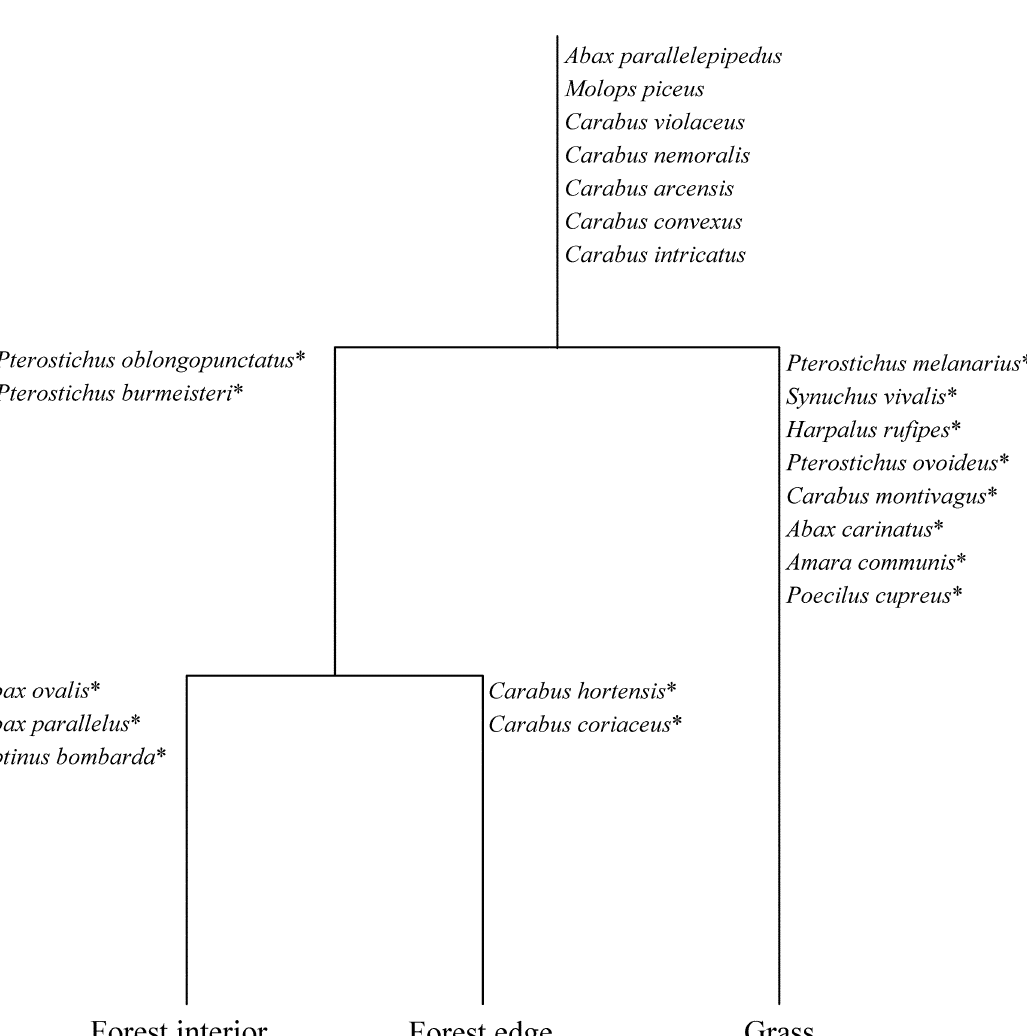
Fig. 3. Dendrogram presenting the indicator species identified by IndVal. Significant indicator species are denoted by * (p<0.05). Only species represented by ten or more individuals are